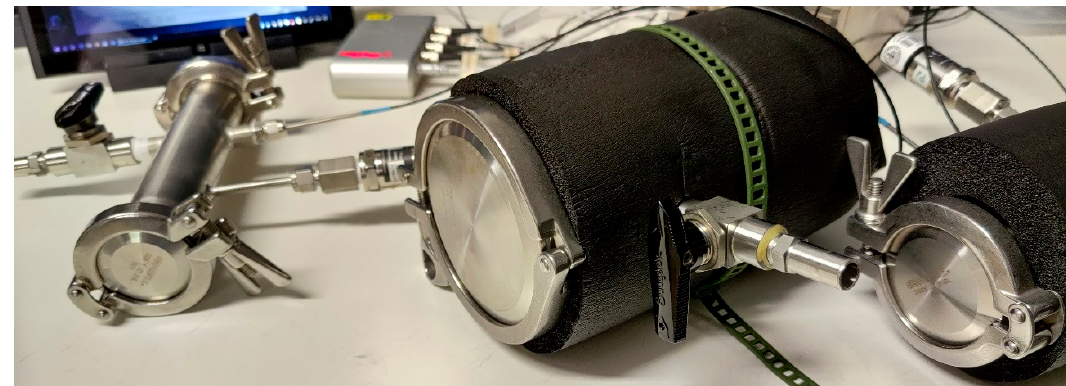
Figure 3. Detail of the three sizes of tested Clamp connectors (DN32, DN50 and DN80) with both blind covers and where the OTR was tested for two gaskets. OTR: Oxygen Transmission Rate.